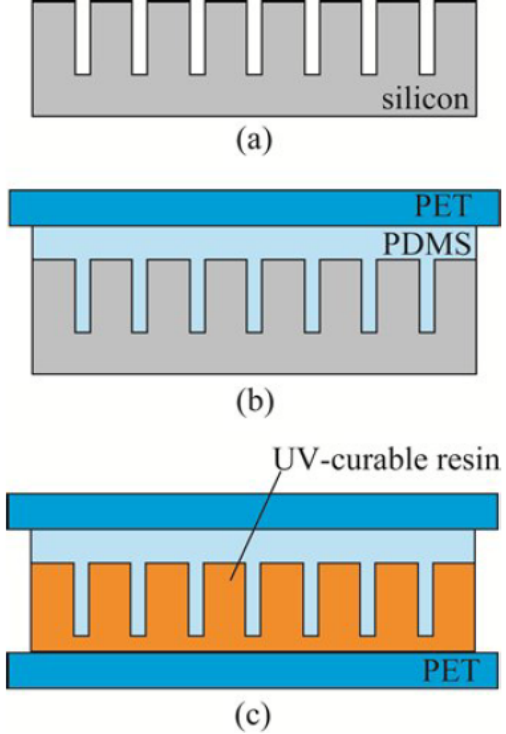
Figure 2. Outline of fabrication process: ( a ) silicon master fabrication by deep-reactive ion etching (DRIE); ( b ) polydimethylsiloxane (PDMS) mold fabrication by casting; ( c ) sample fabrication by UV